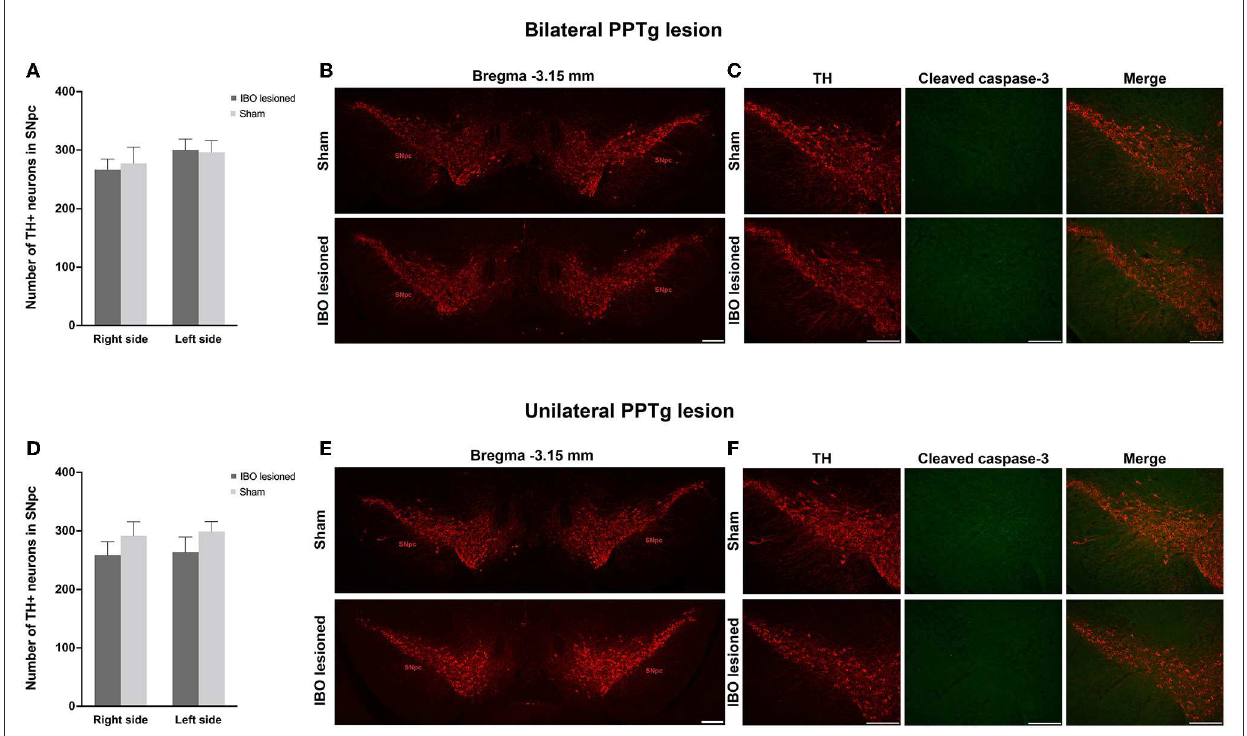
FIGURE6 PPTg IBO lesion did not induce dopaminergic neuron loss and apoptosis in the SNpc. There was no change in the number of dopaminergic neurons (A, B) and apoptosis (C) in the SNpc following bilateral PPTg IBO lesion. In addition, there was no change in the number of dopaminergic neurons (D, E) and apoptosis (F) in the SNpc following unilateral PPTg IBO lesion. Scale bar = 1000 µ m.